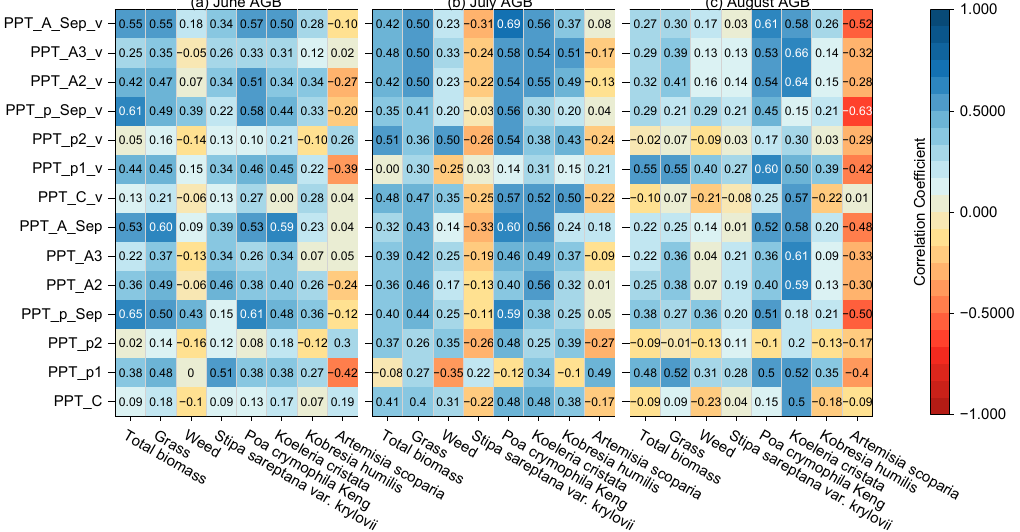
Figure 3. Statistics of AGB variations in different species in different months during 1997–2011. (A) shows slope, while (B) shows R for AGB variations.